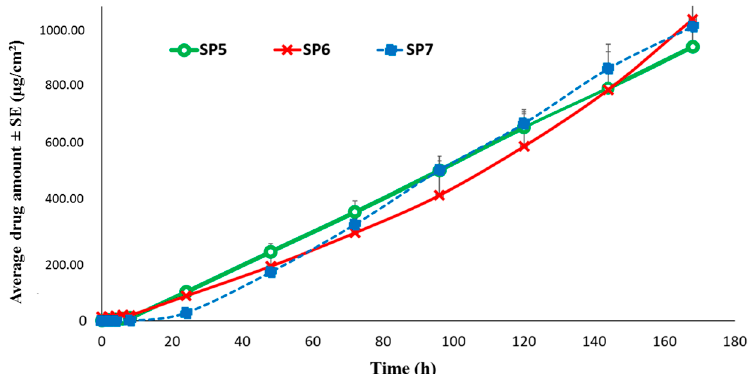
Figure 8. Comparison of permeation profile of silicone based TAF patches through human epidermis. SP5: Silicone-based 15% TAF patch prepared from formulation blend homogenized at 30,000 rpm for 20 min. SP6: Silicone-based 15% TAF patch prepared from formulation blend homogenized at 32,000 rpm for 30 min. SP7: Silicone-based 15% TAF patch prepared from formulation blend homogenized at 32,000 rpm for 5 min.